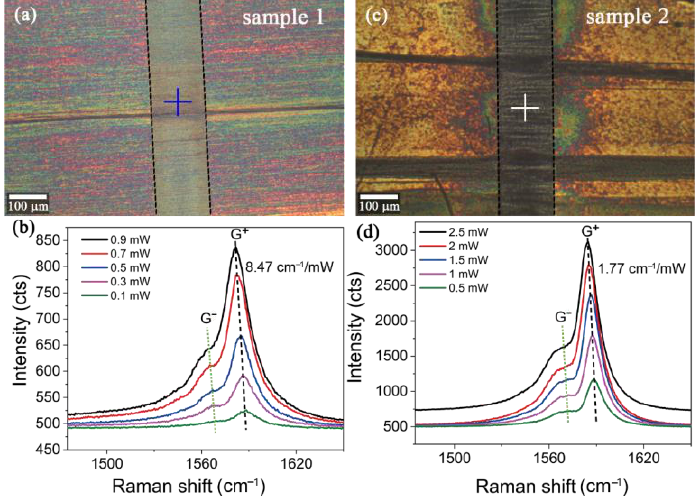
Figure 2. ( a ) Optical image of Sample 1; ( b ) Raman spectra of Sample 1 under different excitation powers; ( c ) Optical image of Sample 2; ( d ) Raman spectra of Sample 2 under different excitation powers. The middle part between the two black dash lines is the suspended CNT film. The widths of the trenches for Sample 1 and Sample 2 are both 120 μ m. The crosses mark the probe points.